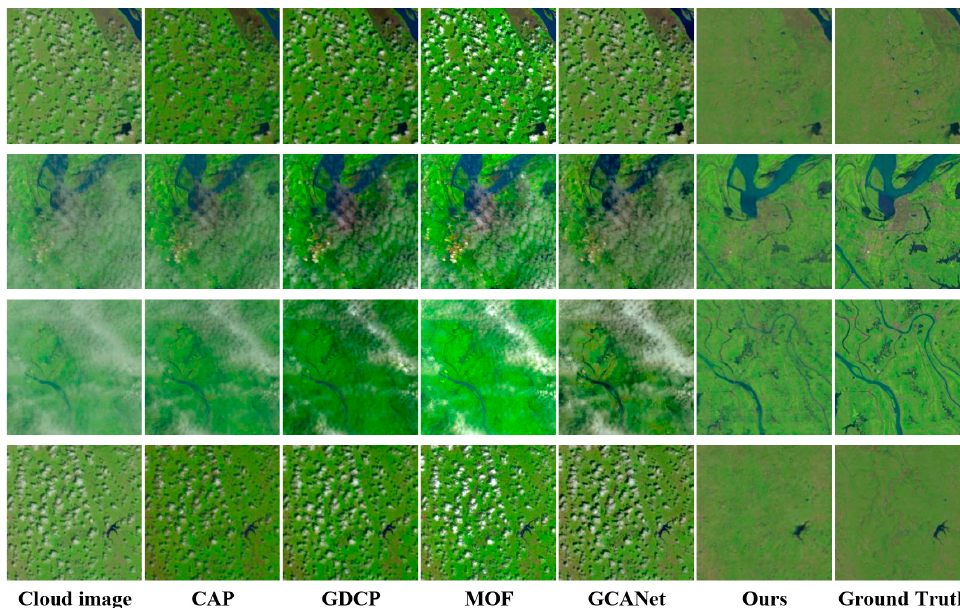
Figure 7. Results of the RICE-II dataset for cloud removal. Table 2. Remote sensing image results (PSNR,